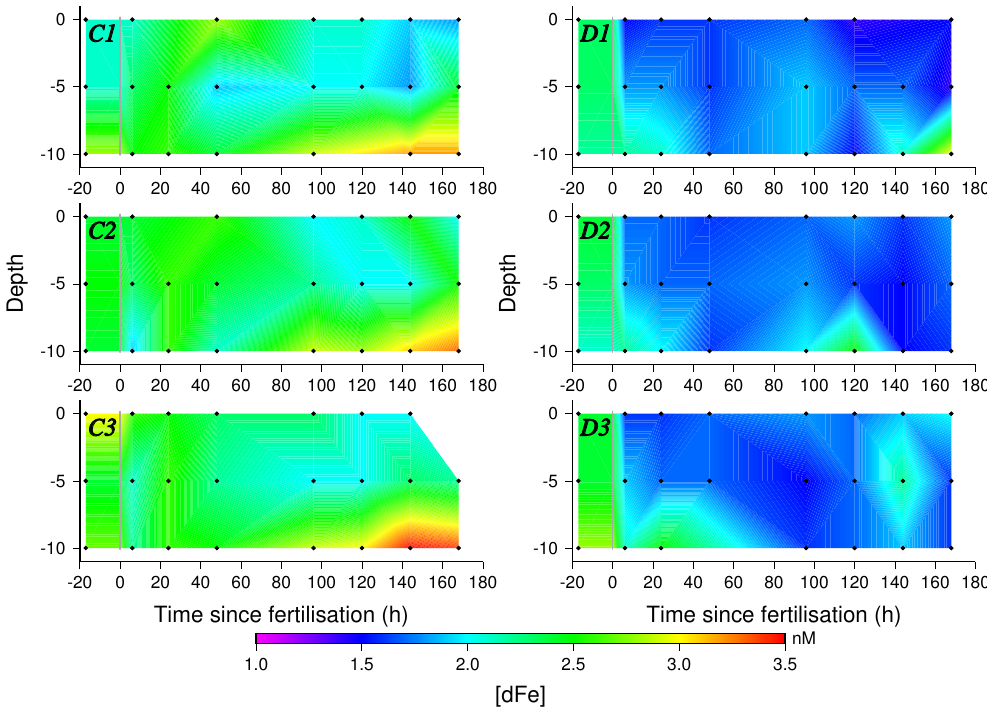
Fig. 1. Evolution of dFe concentrations ([dFe] in nM) during the DUNE-1-P experiment in all mesocosms.